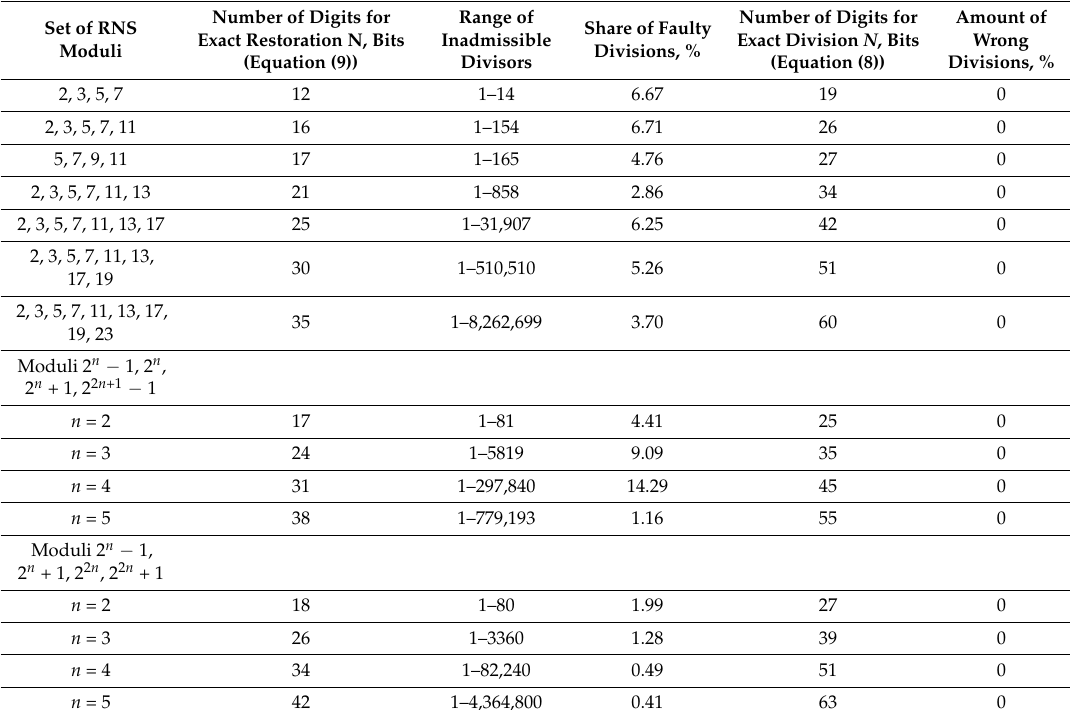
Table 4. Distribution of division errors with insufficient rounding accuracy of N for different sets of RNS